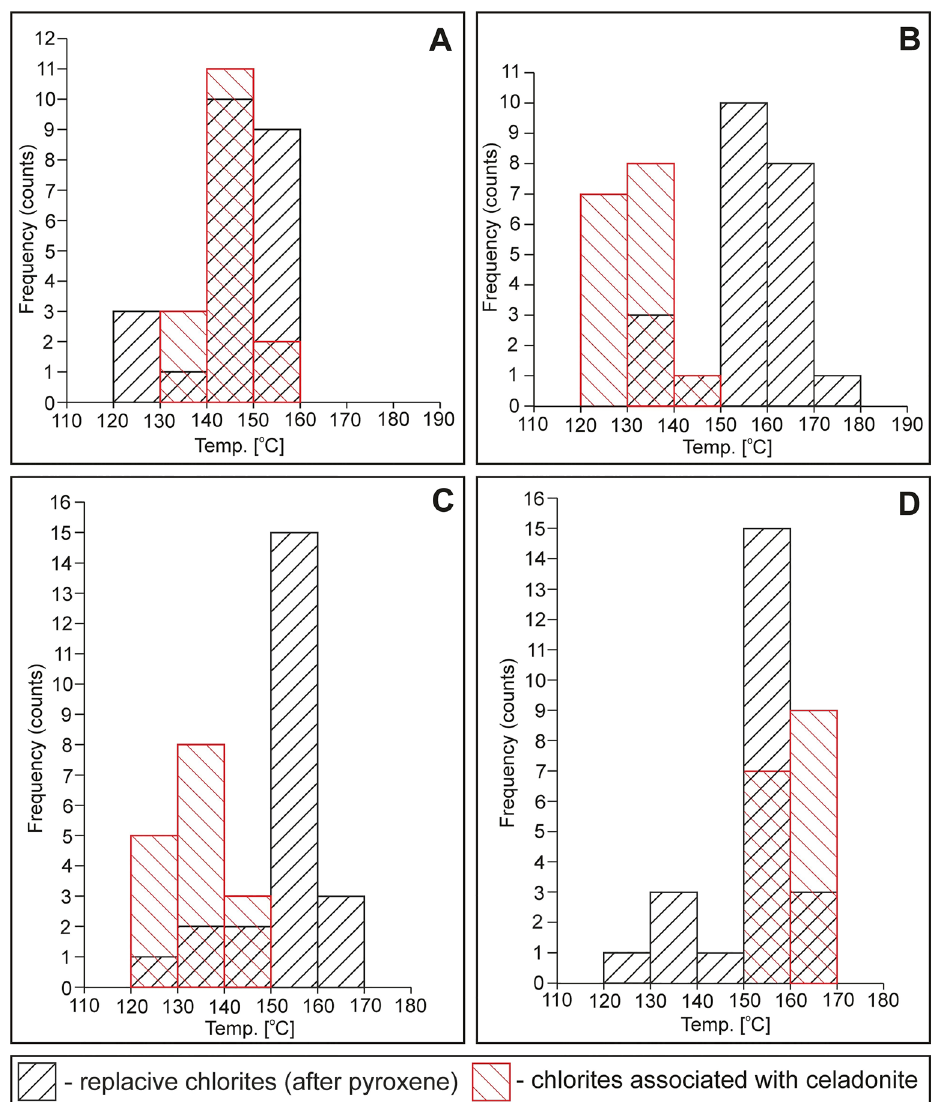
Figure 10 . Frequency histograms showing calculated temperatures of replacive chlorites and chlorites associated with celadonite (non-replacive) based on the empirical (chemical) geothermometers: ( A ) Al IV - and Fe/(Fe + Mg)-based 42 , ( B ) Al IV - and Fe/(Fe + Mg)-based 44 , ( C ) Al IV -based 41 , and ( D ) Al IV - and Fe/(Fe + Mg)- based 43